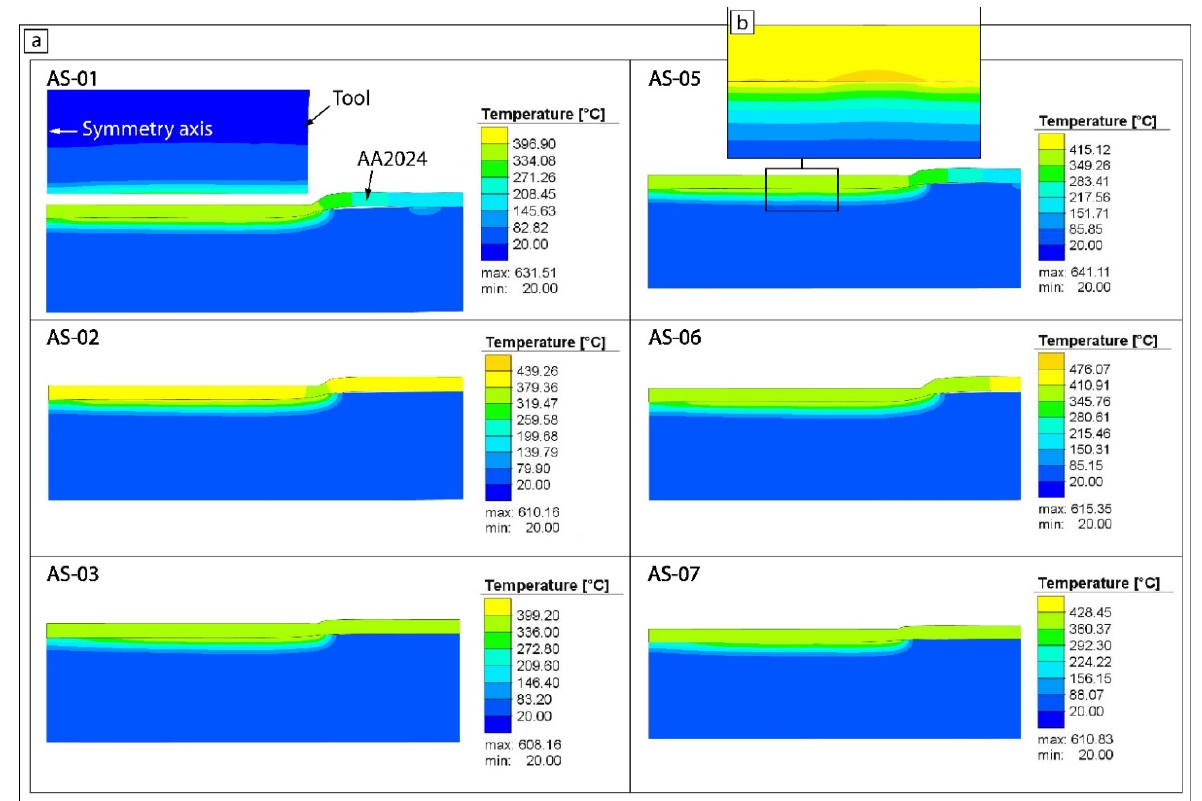
Figure 9. The average temperature distribution profiles ( a ) and peak temperatures on the interface ( b ).